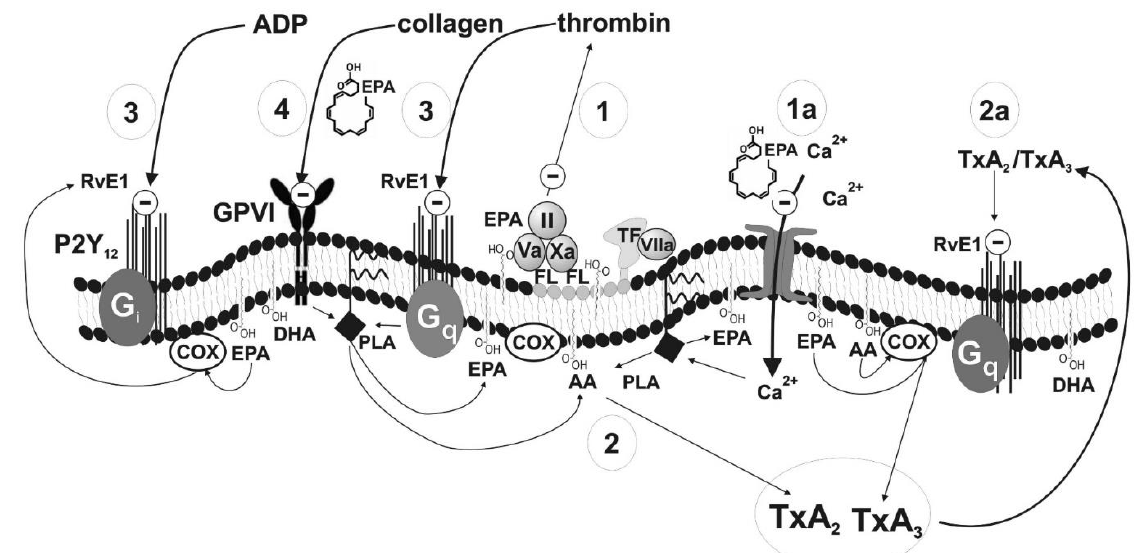
Figure 2. Mechanism of antiplatelet effects of eicosapentaenoic acid (EPA), docosahexaenoic acid (DHA), and their metabolites. Abbreviations: II-Va-Xa: Factors of prothrombin complex; AA: Arachidonic acid; COX: Cyclooxygenase; FL: Membrane phospholipids; GPVI: Collagen receptor; Giq: G proteins; PLA: Phospholipase; P2Y12: ADP receptor; TF: Tissue factor; TXA 2 , TXA 3 : Thromboxanes; RvE1: Resolvin E1. Table 1. Potential mechanisms of antiplatelet effects of EPA and